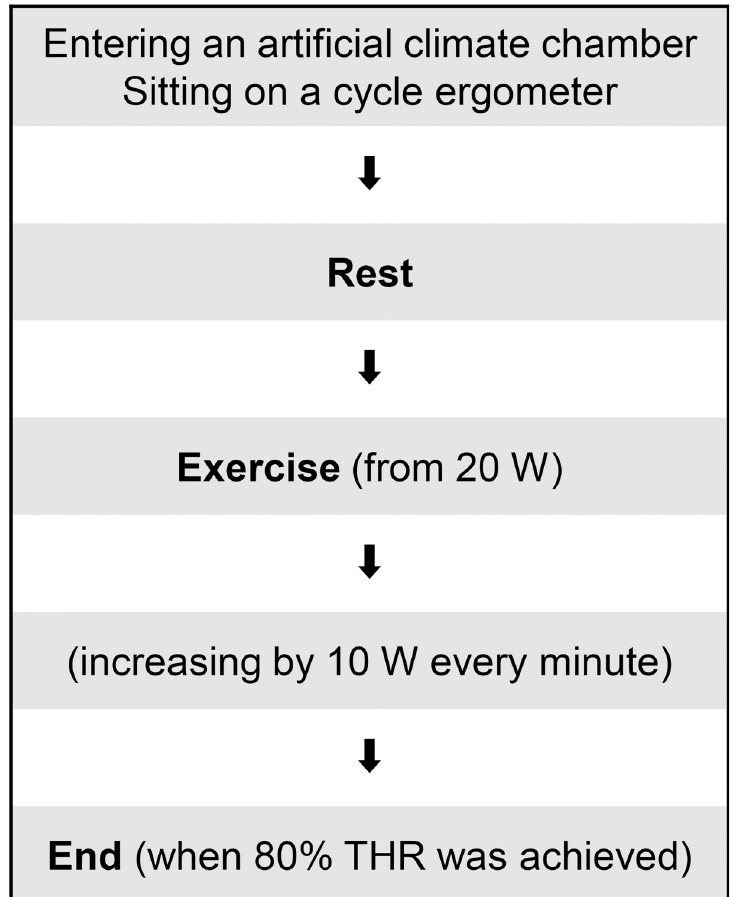
Fig 3. Outline of the experiment for the measurement of the workloads at the maximal oxygen uptake. 80% THR: 80% of the target heart rate.